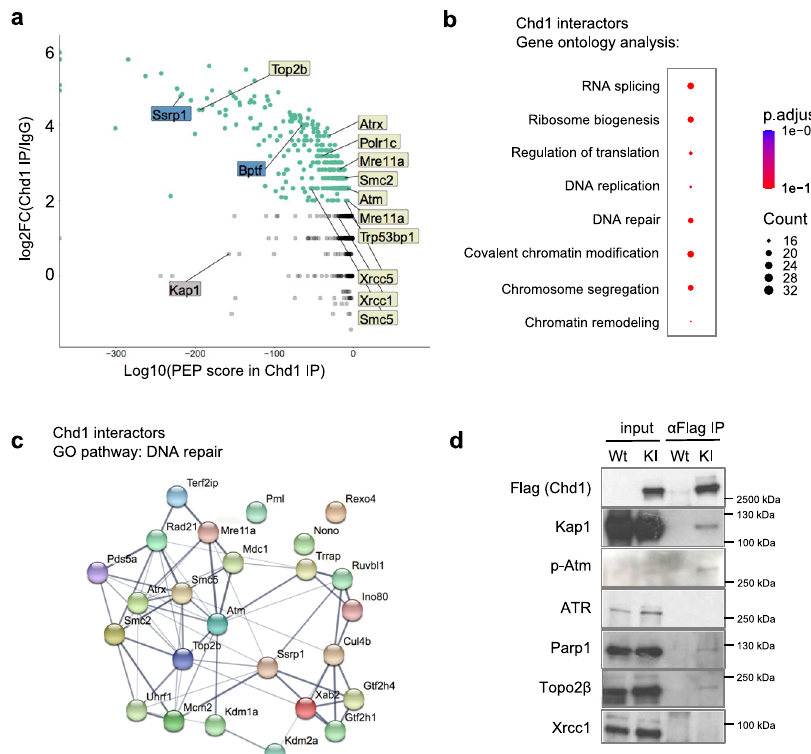
Fig. 1 Chd1 interacts with double-stranded DNA repair proteins in ES cells. a Putative Chd1 interactors, identi fi ed by IP-mass spectrometry using a Chd1- Flag knock-in ES cell line. IgG IP was performed as negative control. Each dot denotes an identi fi ed protein. Green dots indicate proteins that are signi fi cantly enriched in Chd1 IP vs IgG IP. Gray dots indicate detected, but not signi fi cantly enriched, proteins. Previously documented interactors of Chd1 are indicated in blue boxes. Key proteins involved in DNA repair are indicated in cream boxes. Trim28, an interactor identi fi ed in the 250 mM salt IP (Supplementary Fig. 1) is indicated in the gray box. The posterior error probability (PEP) score denotes the probability that the identi fi ed peptide is correct. False discovery rate was set to 1%. (Full list is available in Supplementary Data 1. b Gene ontology analysis of co-immunoprecipitated proteins. Selected pathways are shown. The color scale shows the adjusted p value of the enriched pathways. Full list is available in Supplementary Data 2. c Protein interaction network of factors co-immunoprecipitated with Chd1 and belonging to the gene ontology term “ DNA repair ” . Colors are randomly assigned to genes. d Co-IP validation of the interaction of Chd1 with selected DNA repair proteins. Figure is representative of two biologically independent